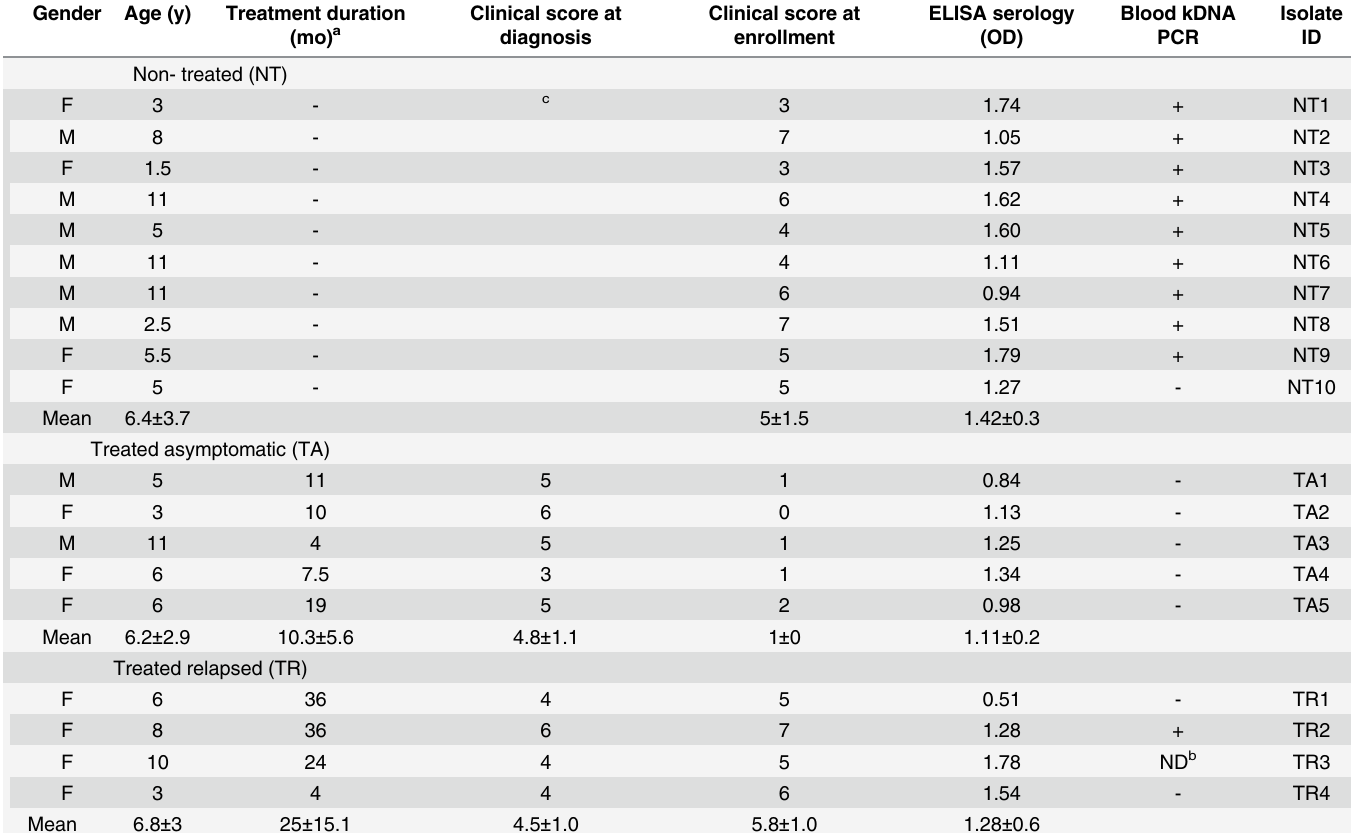
Clinical score at ELISA serology Blood kDNA Isolate enrollment (OD) PCR ID